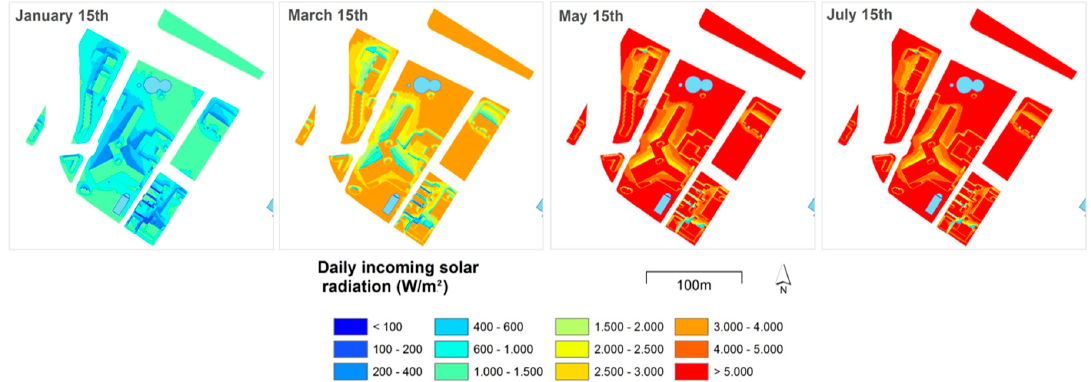
Figure 5. Details of the daily incoming solar radiation model used to correct the theoretical radiation.